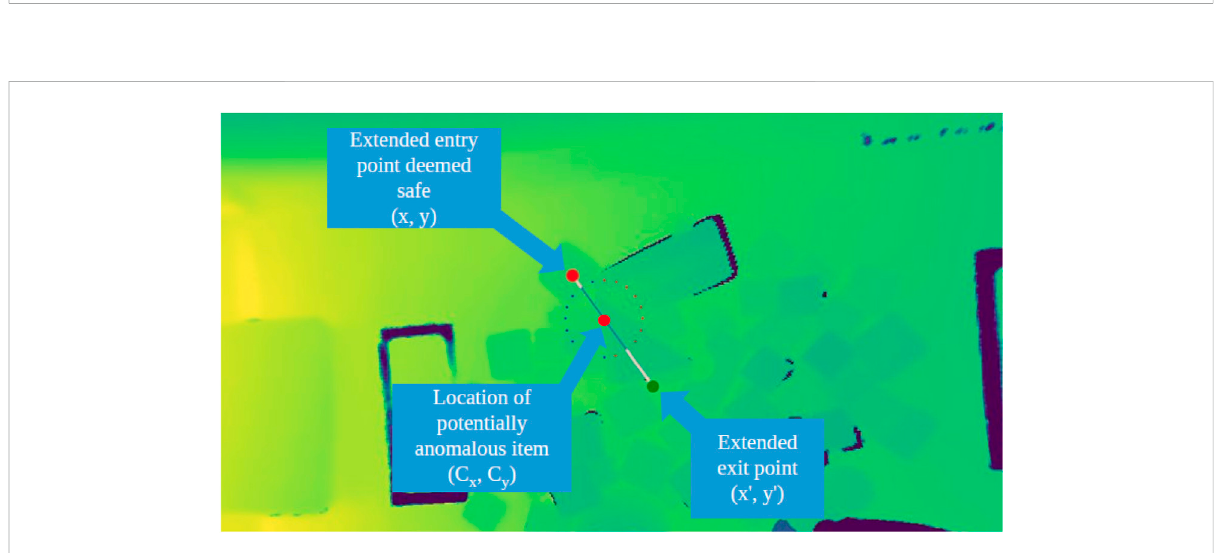
FIGURE 8 Generation of optimized motion primitive to perturb object clutter. The circle shows the radially generated candidate motion plans. In the situation, the entry and exit points of the plan are modi fi ed to prevent collisions with the gripper as it descends into